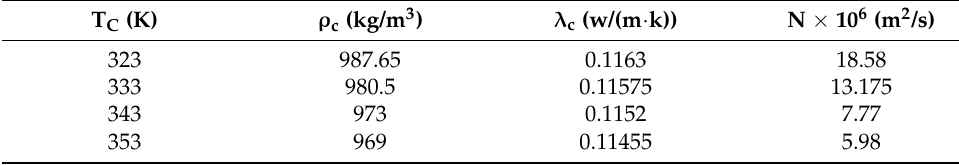
Table 2. Thermal properties of the dispersed phase.